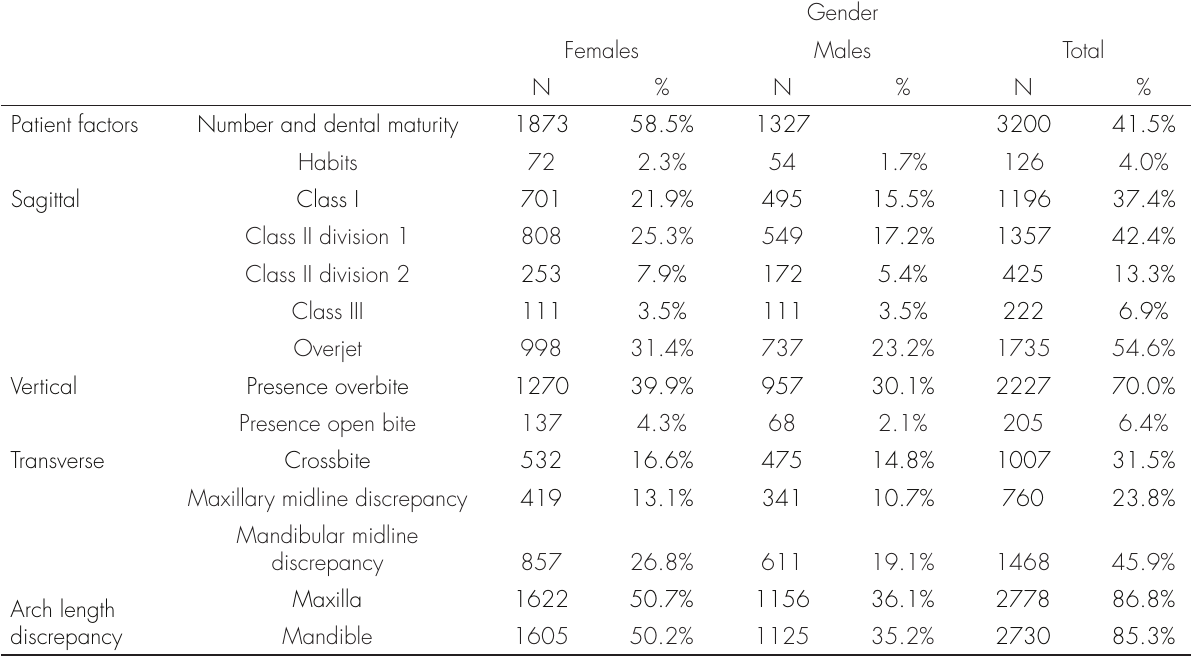
Table II. Summary of orthodontic discrepancies and patient characteristics by